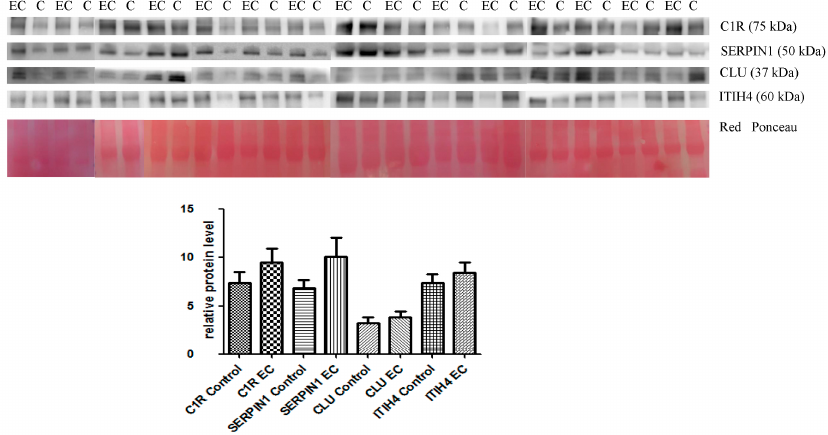
Figure 3. Western blotting analysis of the four proteins ITIH4, CLU, SERPIN1, and C1R in control (C) and endometrial cancer (EC) serum exosome. The intensity of immunostained bands was normalized against the total protein intensities measured from the same blot stained with Red Ponceau (Densitometry Readings available as Supplementary File S2). The graph shows the relative abundance of proteins in control and endometrial cancer serum exosomes. The levels of the proteins were not significantly associated with EC. Results are shown as a histogram, each bar representing mean ± standard deviation (C1R control mean = 7.42 ± 4.25, C1R ADK mean = 9.51 ± 5.33; SERPIN1 control mean= 6.84 ± 3.41, SERPIN1 ADK mean = 10.09 ± 7.57; CLU control mean = 3.24 ± 2.47, CLU ADK mean = 3.87 ± 2.39; ITIH4 control mean = 0.27 ± 0.23, ITIH4 ADK mean= 0.39 ± 0.34).